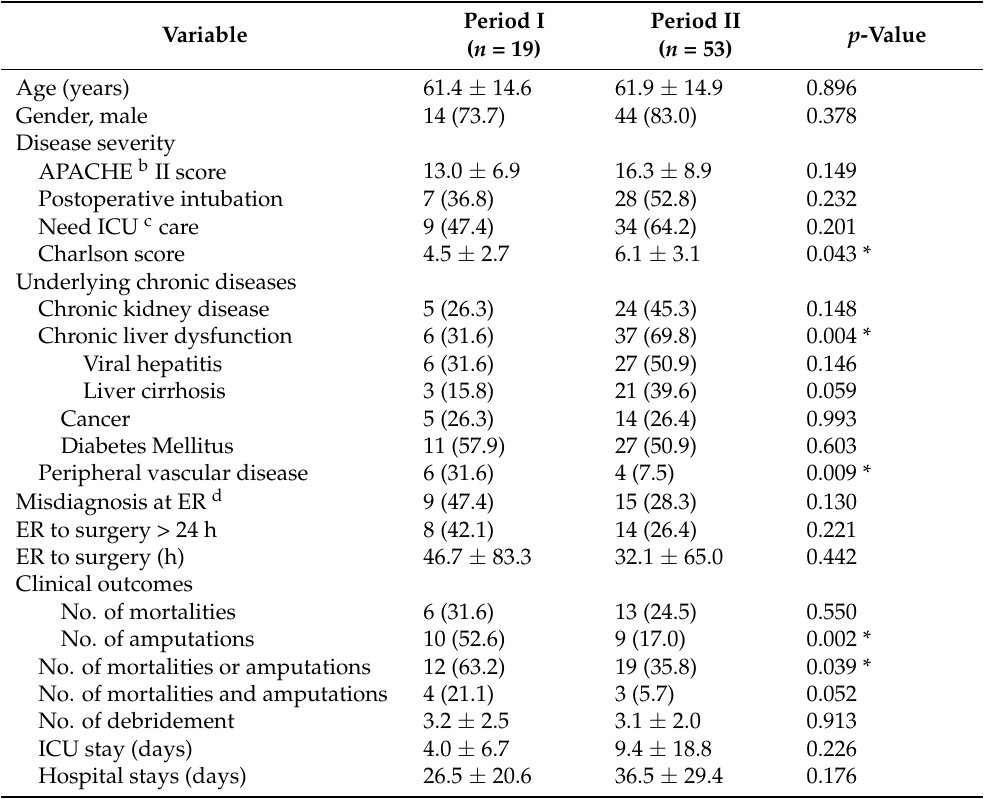
Table 1. Demographic data, characteristics, and clinical outcomes of 72 patients with Aeromonas NF a between periods I and